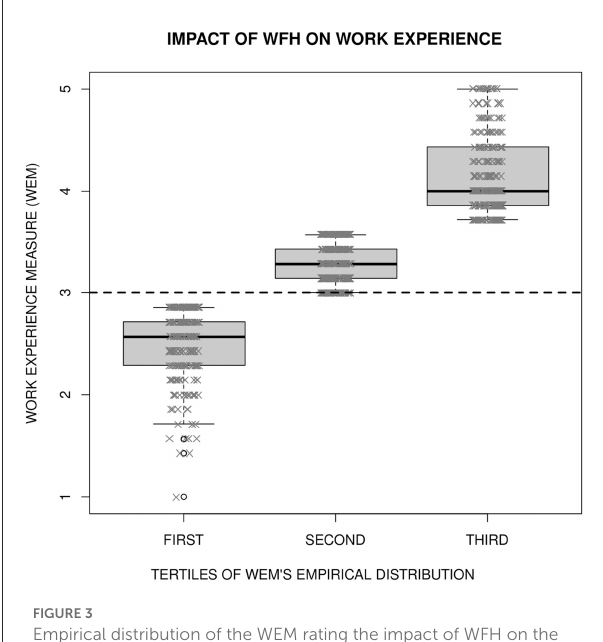
FIGURE3 Empirical distribution of the WEM rating the impact of WFH on the work experience in the three classes defined by the tertiles 3 and